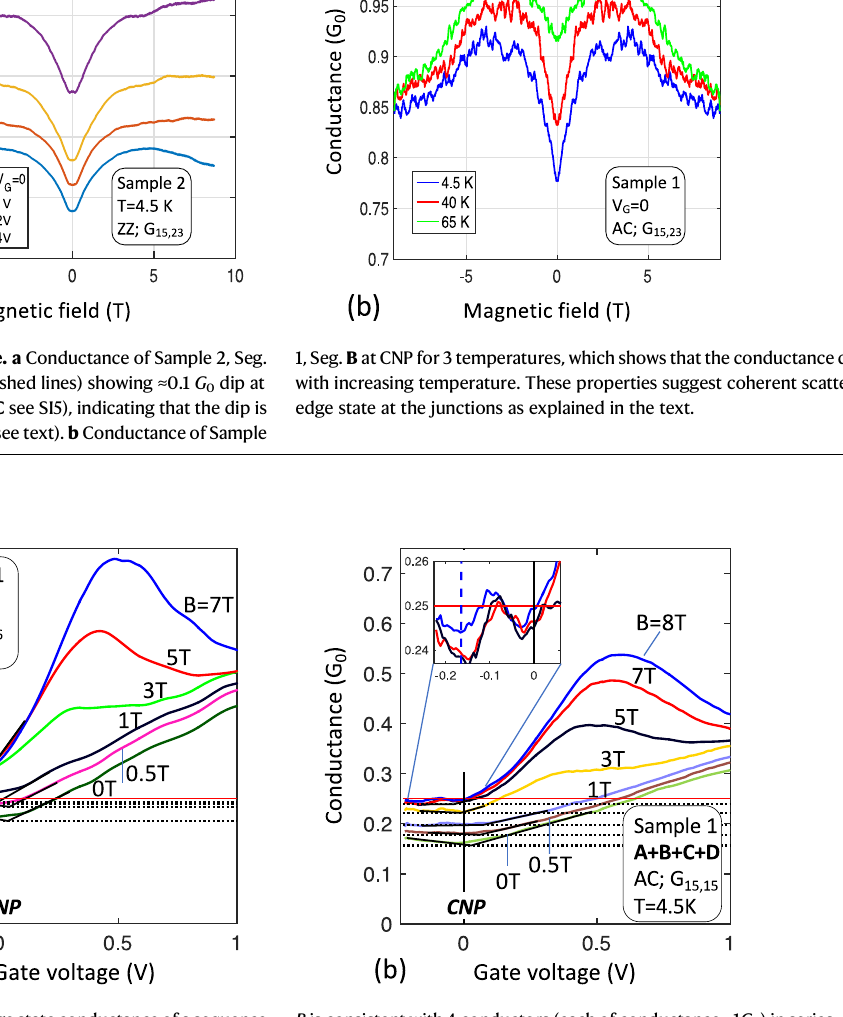
Fig.5|Segmentationoftheedgestate. Theedgestateconductanceofasequence of N segments in series approaches G 0 /N . a 2-point conductance G EH ( V G ), ZZ, for variousmagnetic fi elds B .AtCNP( V G =0),forlarge B , G EH ≈ ½ G 0 ,isconsistentwith a ballistic conductor with 1 isotropic scattering center (the junction). b 2-point conductance G ABCD ( V G ),AC,forvarious B .AtCNP( V G =0)theconductanceatlarge